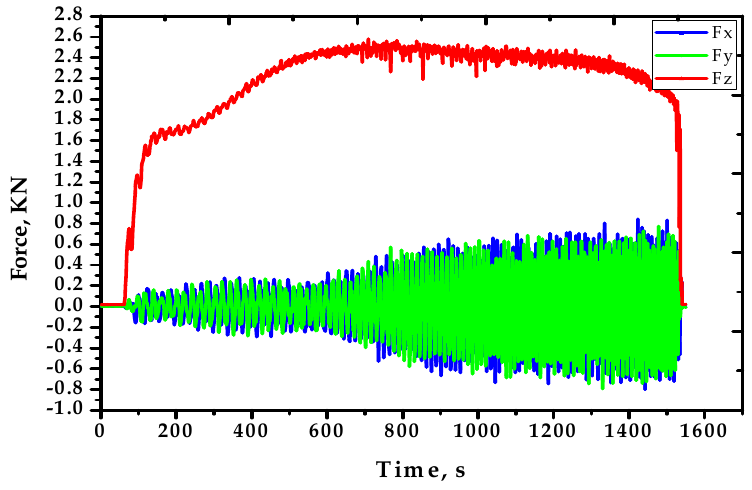
Figure 17. Forming forces in the three directions for the cone produced with run 8.